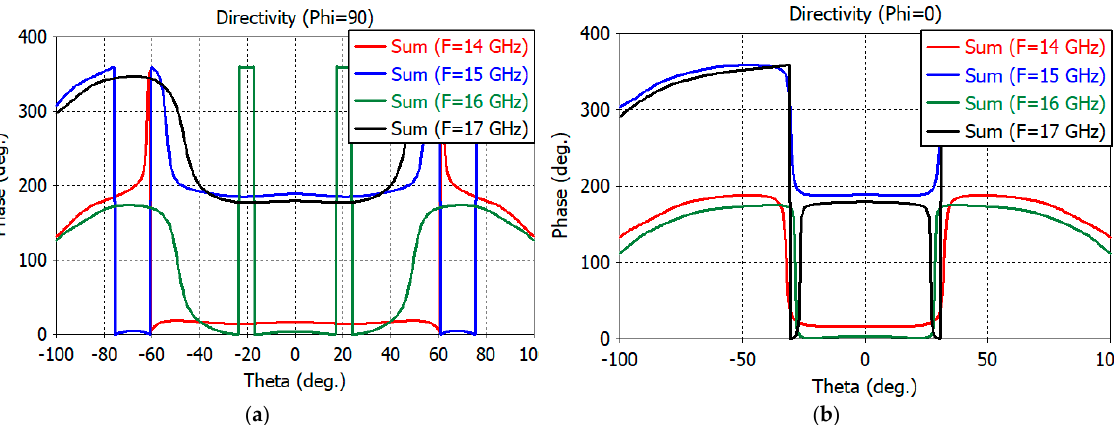
Figure 6. ( a ) E -plane phase patterns of the sum channel. ( b ) H -plane phase patterns of the sum channel.